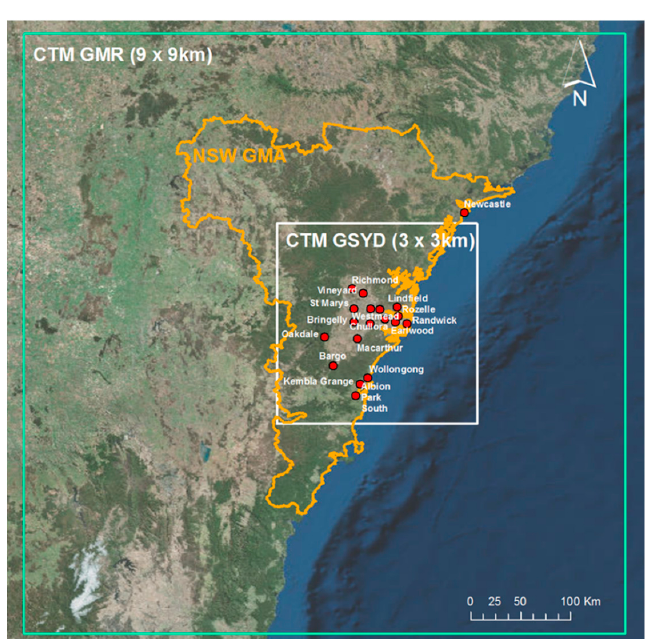
Figure 2. Modelling domains for the NSW Greater Metropolitan Region (CTM GMR) and Greater Sydney (CTM GSYD). The NSW Greater Metropolitan Area (NSW GMA) domain (as defined in the Clean Air Regulation 2010) is also shown, and locations of NSW air quality monitoring stations referenced in the study are identified with red dots.